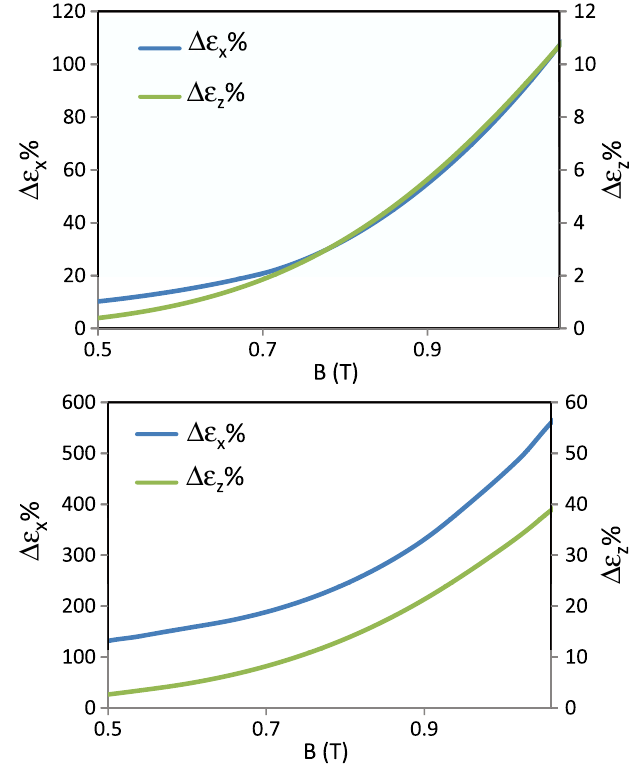
FIG. 7. (Color) Emittance evolution as a function of applied field. Top: parallel initial beam. Bottom: diverging initial